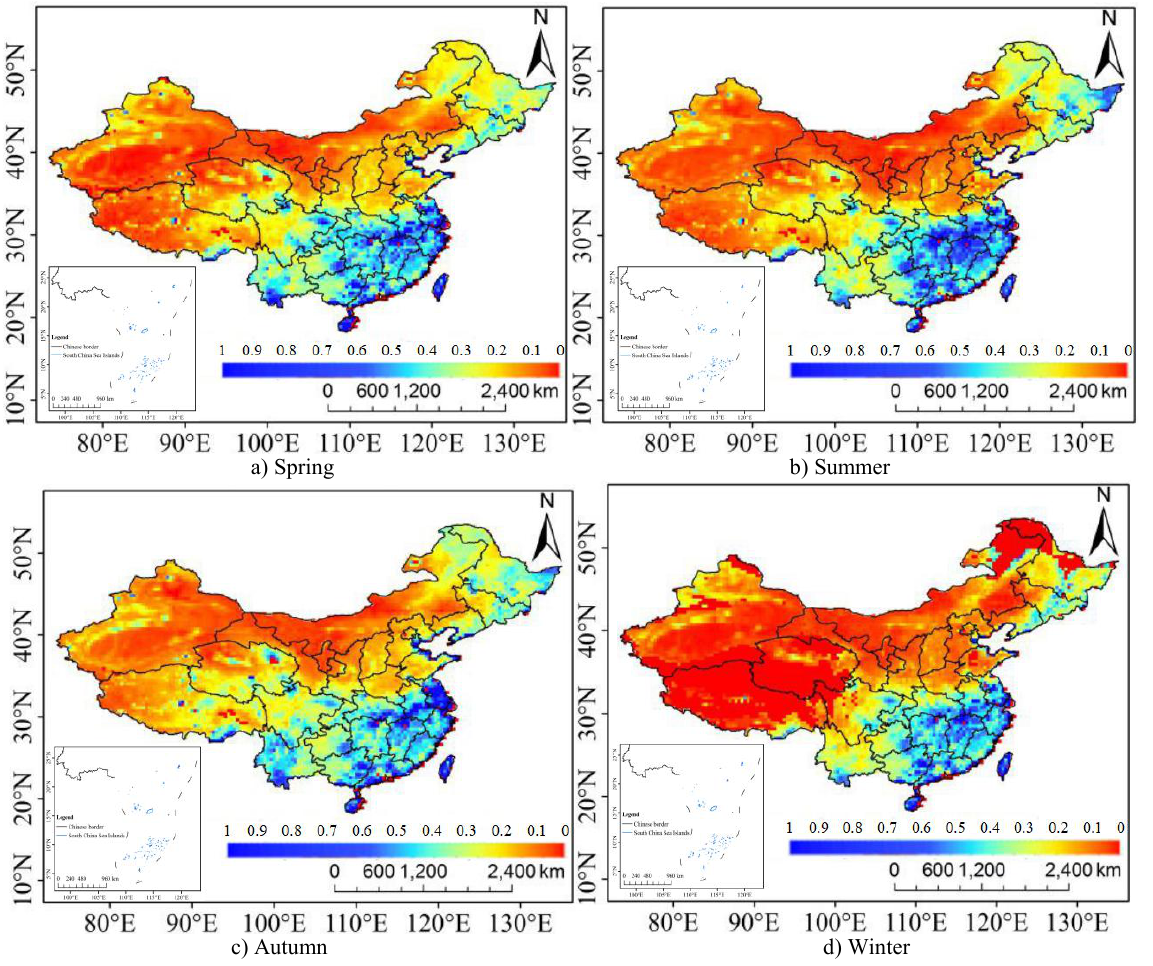
Figure 3 Quarterly Average Distribution Map of Soil Moisture in China